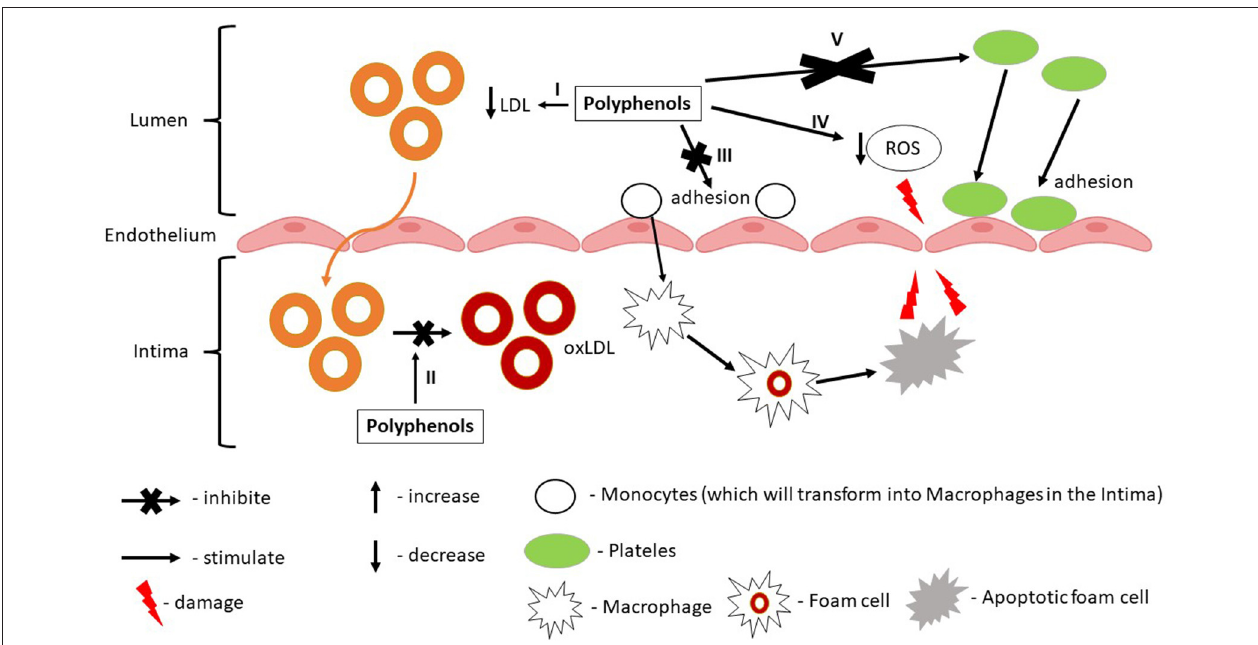
FIGURE 3 | Synergistic and prophylactic effect of grapevine and wine by-products polyphenols in ischemic heart disease. I—Polyphenols reduce LDL levels; II—Polyphenols reduce oxLDL formation; III—Polyphenols reduce monocytes adhesion by reducing the expression of VCAM-1; IV—Polyphenols reduce ROS production; V—Polyphenols inhibit platelets activation and adhesion by reducing the expression of PECAM-1.